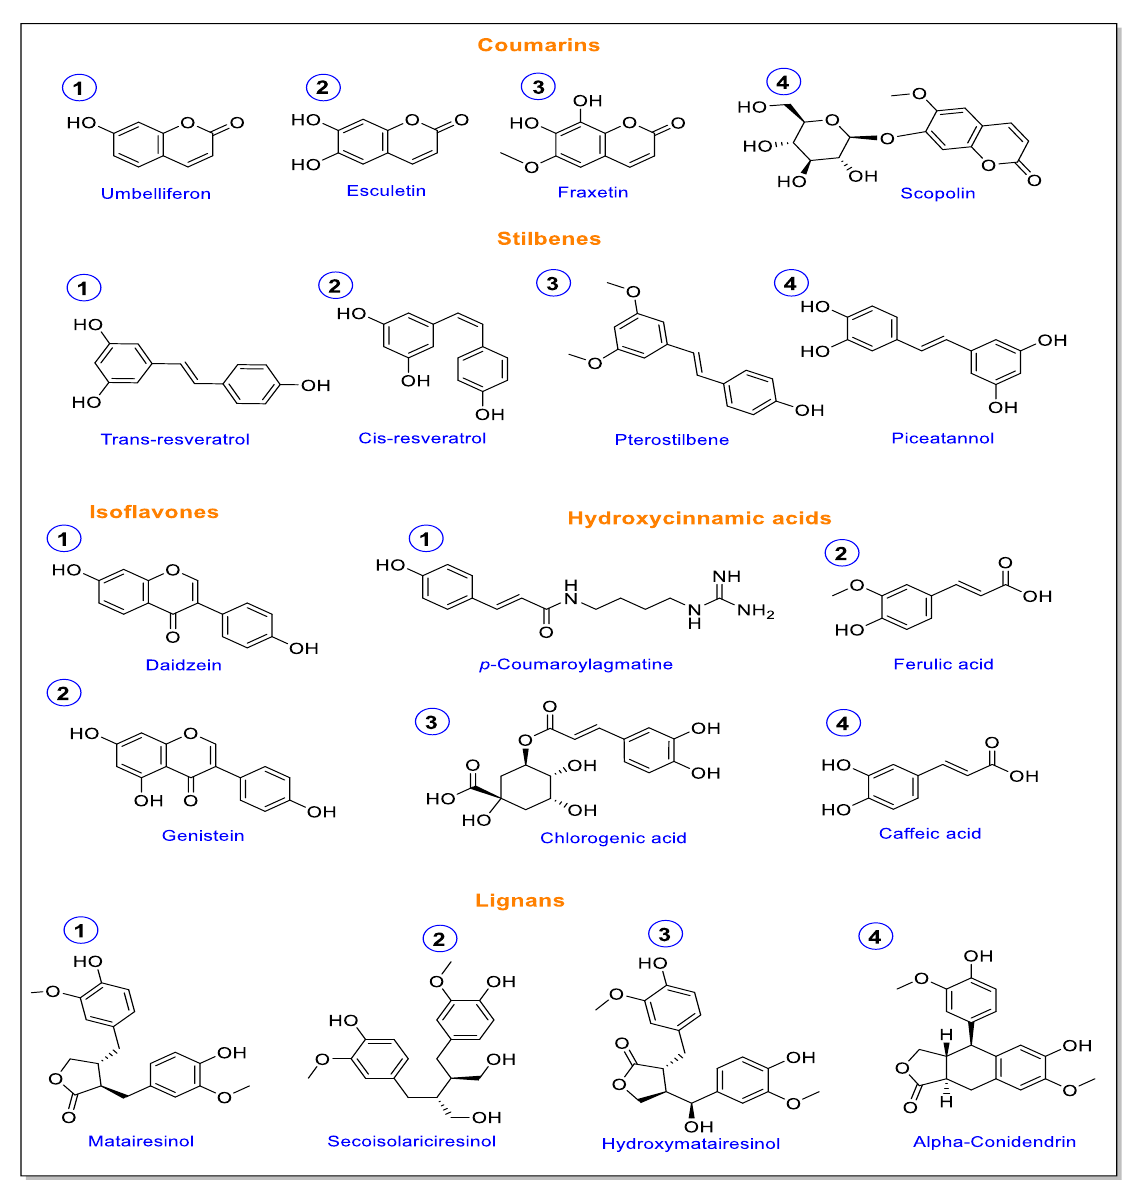
Figure 3. Non-lignin defense metabolites associated with the lignin biosynthetic pathway. This Figure was created using ChemDraw Professional, version 20.0.41, and the structures were analyzed and confirmed using https://pubchem.ncbi.nlm.nih.gov/ structure inquiry (accessed on 16 December 2022).